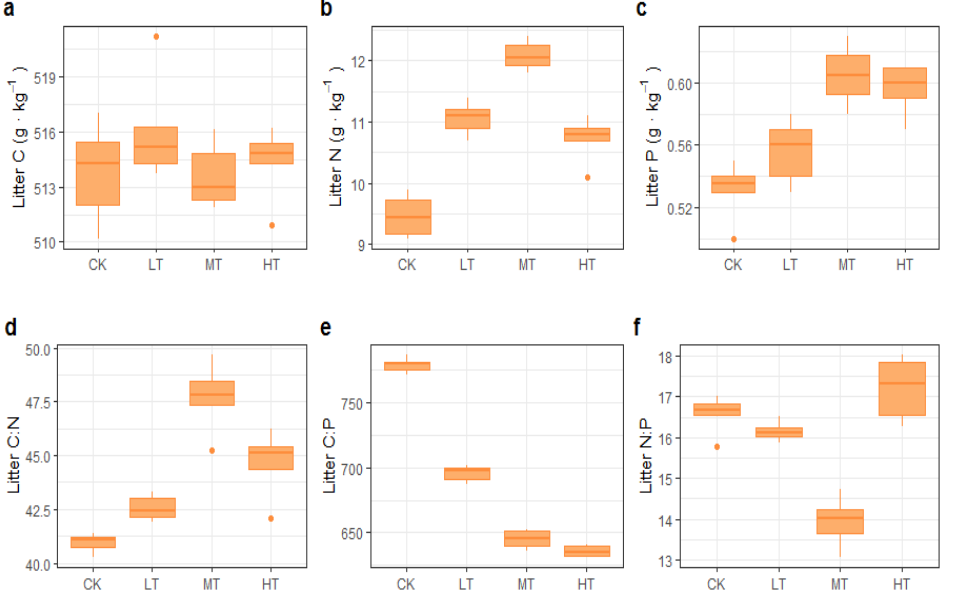
Figure 3. Changes in litter C, N, and P content ( a – c ) and litter C:N, C:P, and N:P ratios ( d – f ) among four thinning treatments.